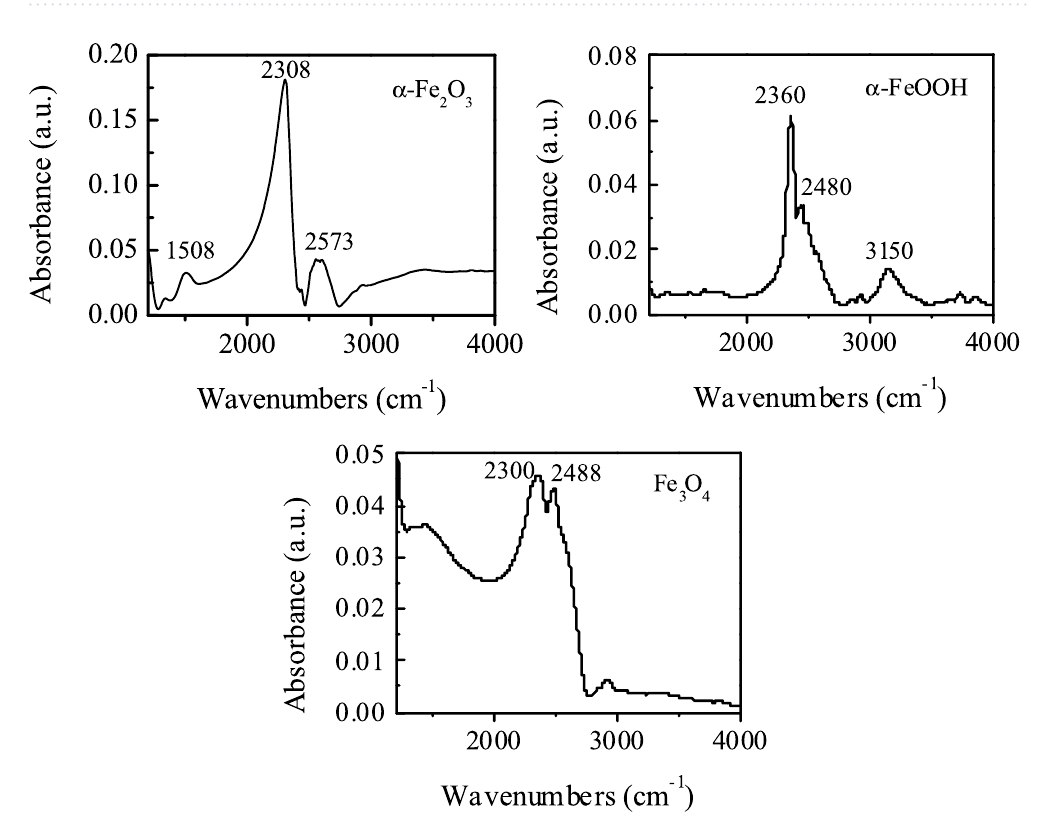
Figure 3. ATR-FTIR spectra of different iron oxide suspensions in D 2 O. (Catalyst concentration: 100 g L − 1 , pD: